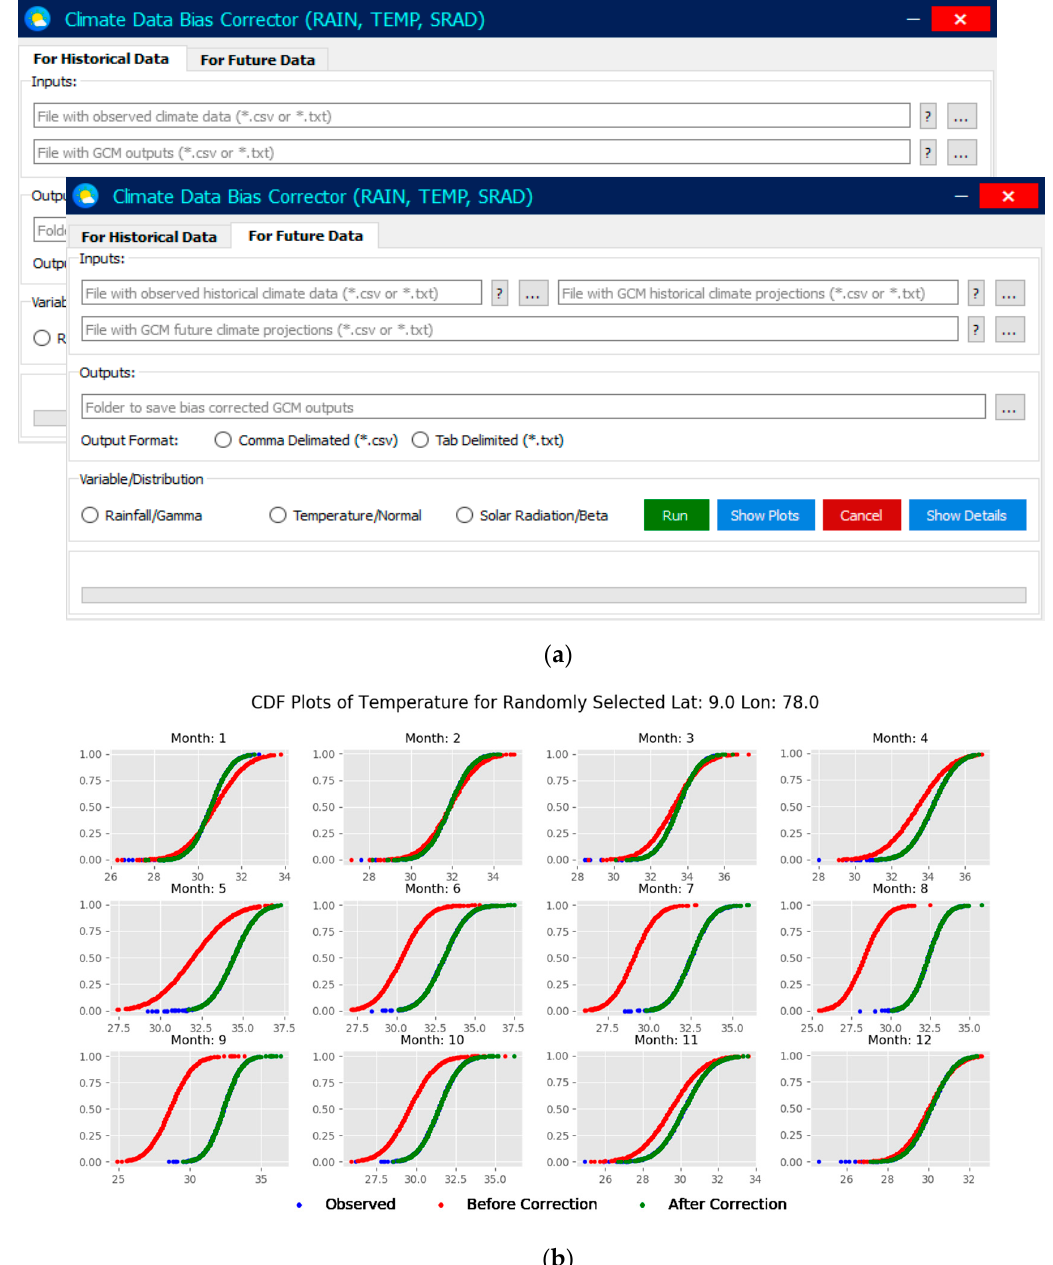
Figure 2. ( a ) Graphical user interface (GUI) of Climate Data Bias Corrector (CDBC), and ( b ) tool generated cumulative density function (CDF) curve of temperature on a monthly basis for a randomly selected grid for comparison of observed, before and after bias correction time series.